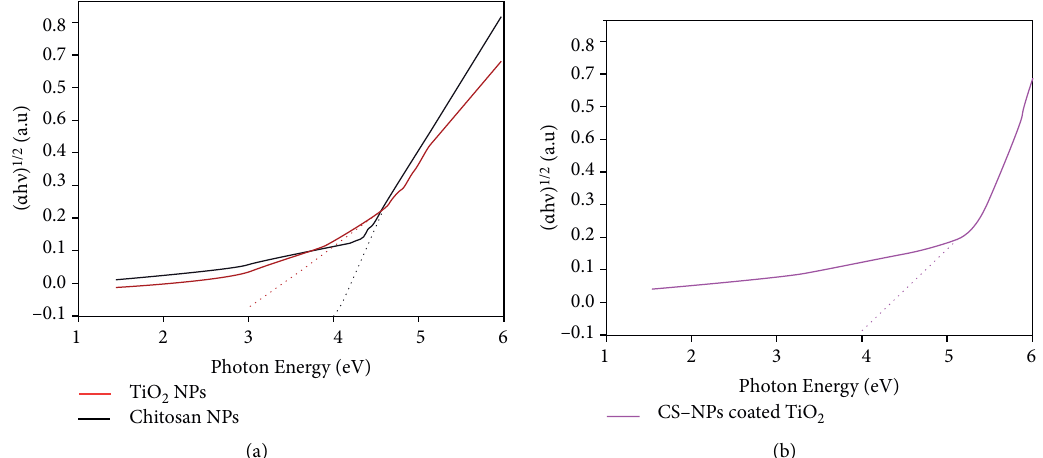
Figure 5: Calculations of band gap of synthesized formulations. (a) TiO